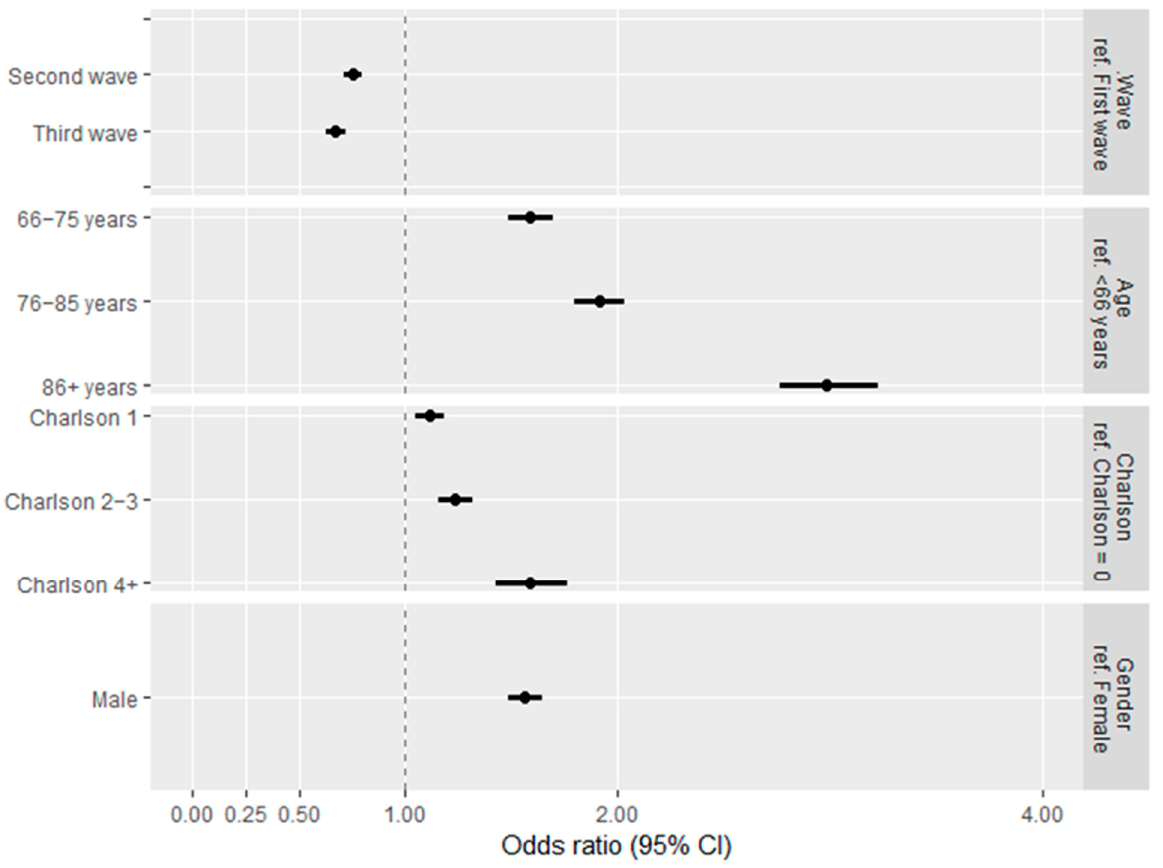
Figure 4. Odds ratio (OR) and 95% confidence interval (CI) estimates showing the effect of being infected in different waves on the combined outcome mortality and ICU admission, adjusting by age, gender, and comorbidity burden.